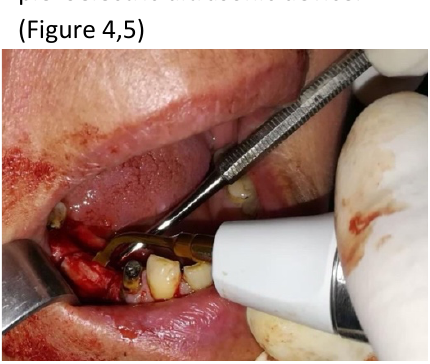
Figure 1. Initial CBCT radiograph before the alveolar osteogenic